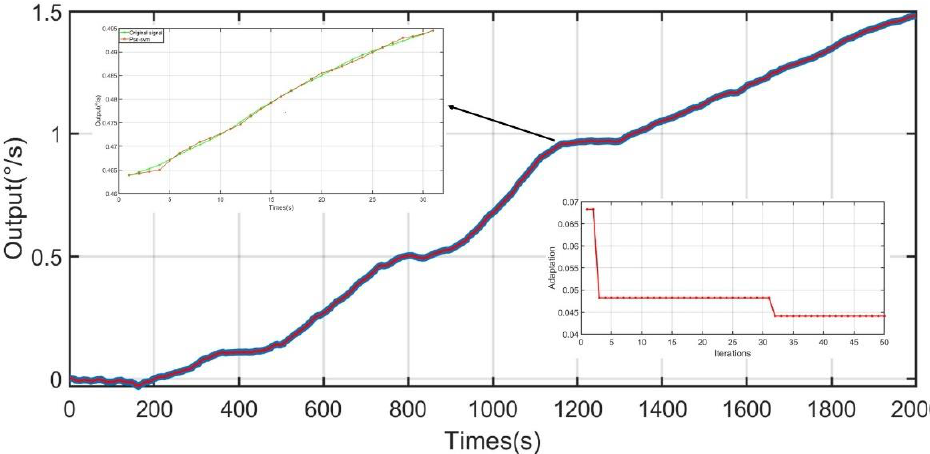
Figure 19. Temperature noise denoising based on PSO-SVM ( −4 0 – 60 °C).